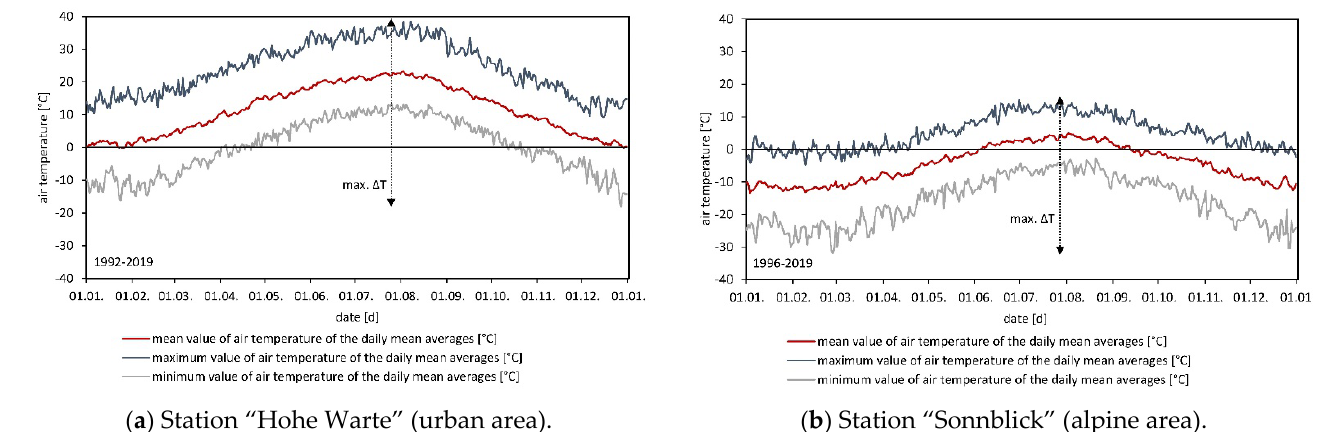
Figure 2. Overview of the air temperature values of the daily mean averages; values are taken from [24].